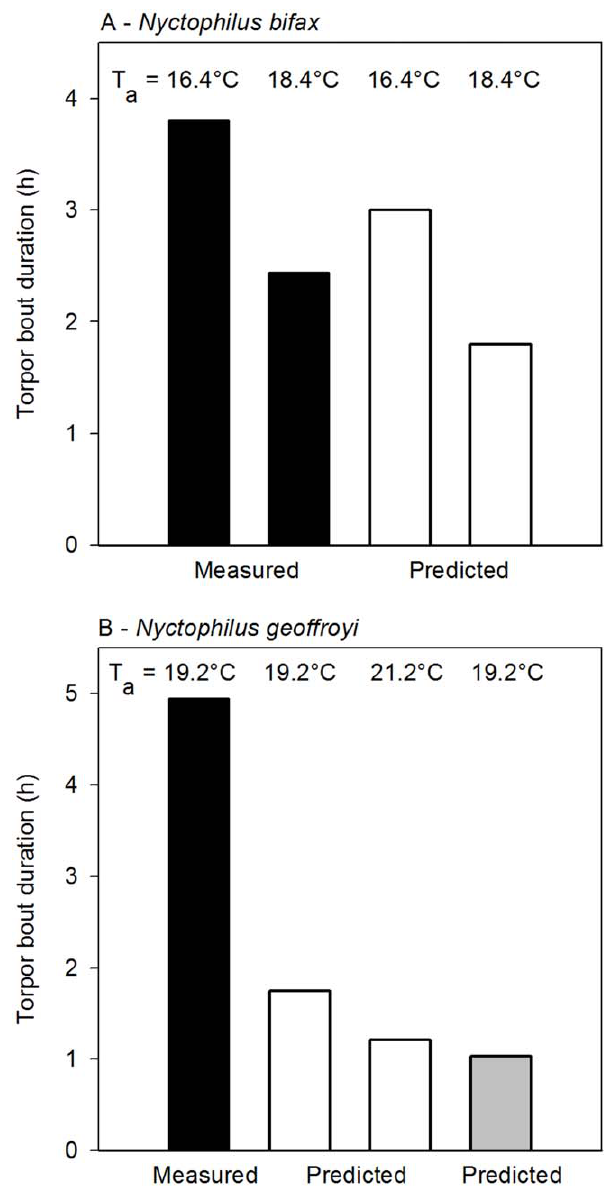
Figure 6. Measured and predicted changes in torpor bout duration in relation to predicted increases in T a . Measured (black bars) and predicted (white and grey bars) torpor bout duration in tropical and subtropical N. bifax (A), and in tropical and temperate N. geoffroyi (B). Measured values are those obtained at the tropical sites at the mean minimum T a (T a 16.4 u C and T a 16.4 + 2 u C N. bifax , T a 19.2 u C only for N. geoffroyi because no T a -torpor bout duration regression is available). Predicted torpor bout durations were calculated from regressions in subtropical N. bifax [36] and from temperate N. geoffroyi in summer (white bars, [22]) and winter (grey bar, [23]).